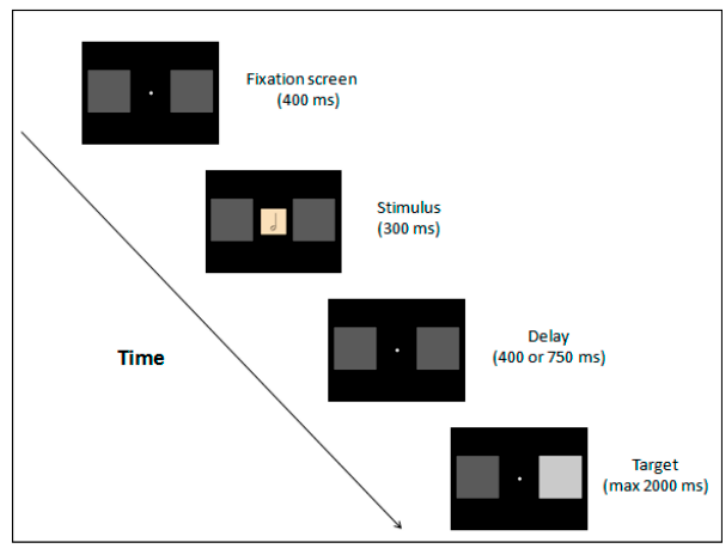
Figure 11. Task sequence employed by Prpic [43]. In this example, the stimulus was the half note and the target appeared on the right visual field.